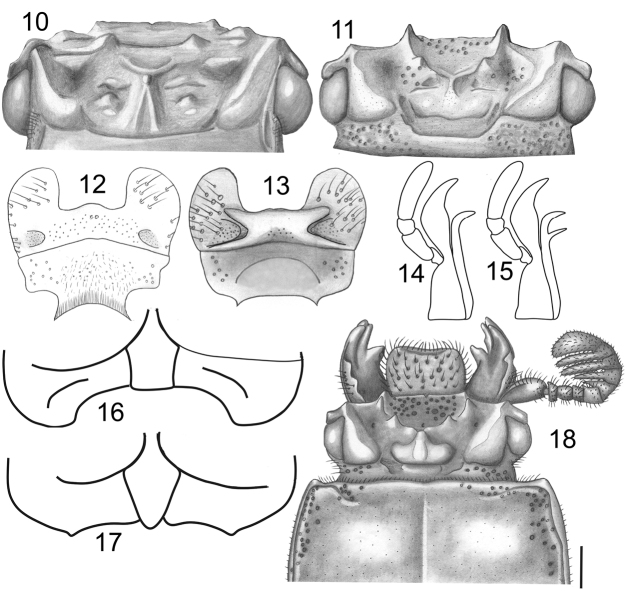
10, 11 Head: 10Veturius sp. 11Paxillus sp. 12, 13 mentum, ventral view: 12Paxillus
leachi13Passalus sp. 14, 15 ventral view of right maxilla: 14Paxillus15Passalus16, 17 Prosternelum: 16Paxillus17Passalus18 head and anterior part of pronotum of Paxillus
martinezi. Scale bar: 1 mm.